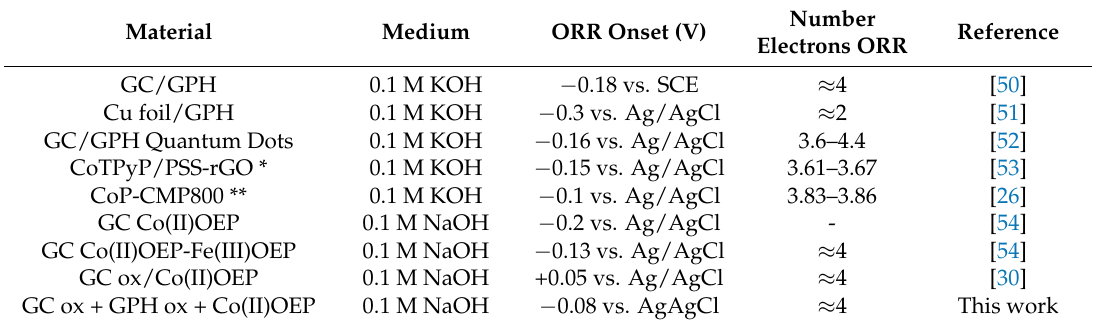
Table 3. Comparison between similar systems towards the oxygen reduction reaction (ORR).